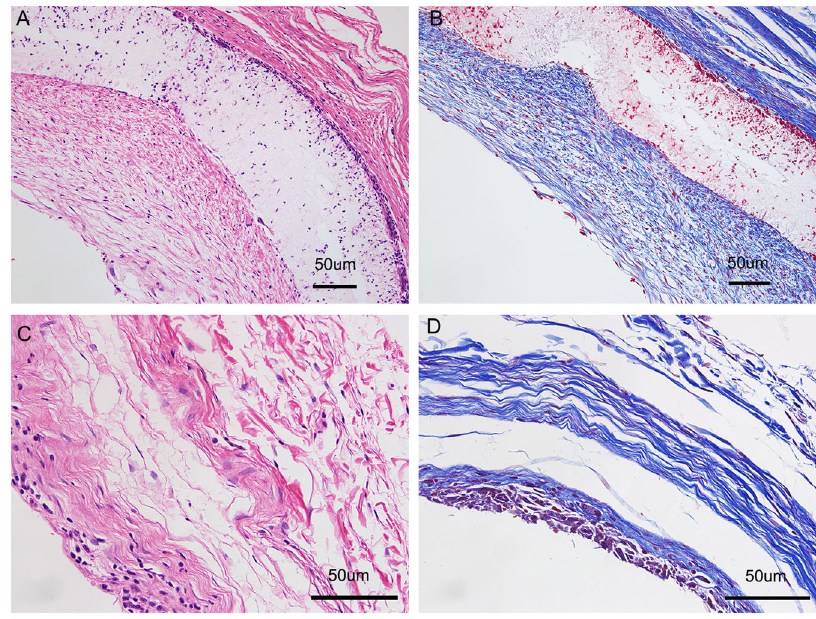
Fig. 4 Histological cross- sectional photos of the biotube and tissue capsule. Haematoxylin and eosin ( A ) and Masson,s trichrome stain ( B ) for the biotube. Haematoxylin and eosin ( C ) and Masson,s trichrome stain ( D ) for the tissue